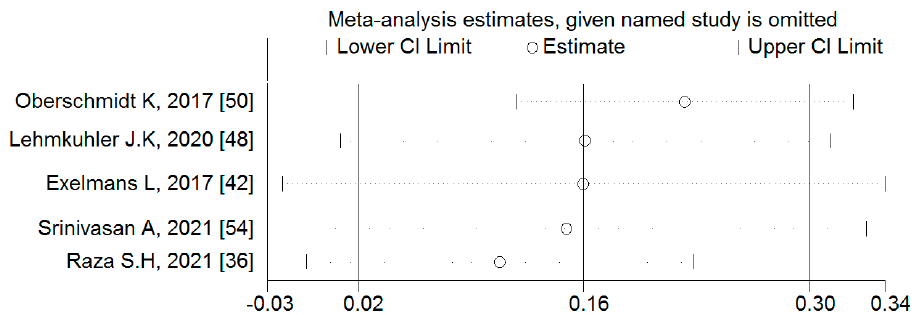
Figure 17. The sensitivity analysis plot assessing the small study effect in the estimated pooled Fisher’s z-score in the association between binge-watching and insomnia.